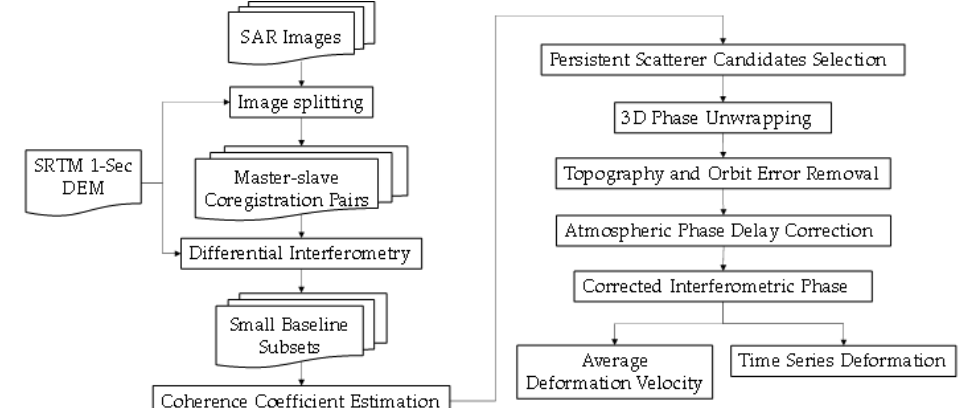
Figure 3. Procedures of SBAS-InSAR method based on SNAP-StaMPS workflow. Taking the image of 12 November 2020 as the super-master image, the time baseline threshold is set to 72d, and 90 interferometric pairs can be obtained. The small baseline dataset combinations are shown in Figure 4.